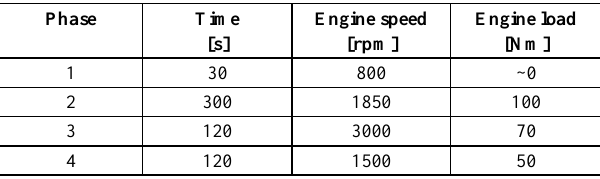
Table 2. Parameters of the 4-phase engine